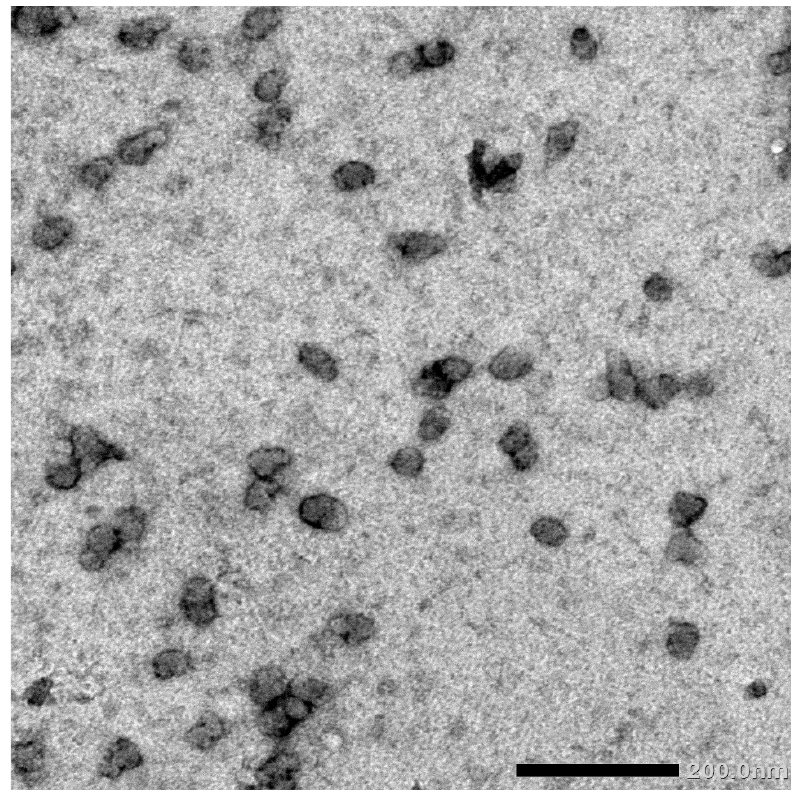
Figure 4. TEM micrograph of the synthesized NFHDE/AK.